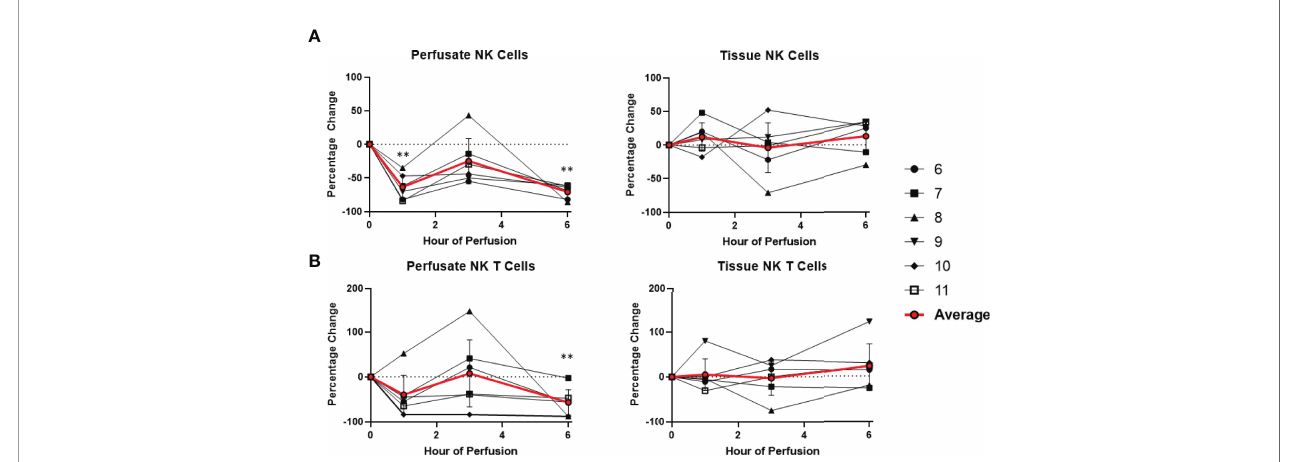
FIGURE 6 | Percentage change of frequency of cells from NK cell lineage during perfusion. A percentage change of 0% suggests there is no change in the innate immune cell frequency from time point 0 th hour. Average values of percentage changes (red line) as well as standard deviations were calculated (vertical bar). A two- sided, paired t-test was performed to compare percentages of each time point to those at time 0H. (** P<0.01). (A) Perfusate NK cell frequency decreased at the 1 st hour of perfusion (-63.4 ± 17.8%) and remained decreased at the 6 th hour of perfusion (-70.7 ± 9.8%), without changes to tissue NK cell frequency. (B) Perfusate NK T cell frequency decreased at the 6 th hour of perfusion (-56.8 ± 28.5%) without changes to tissue NK T cell